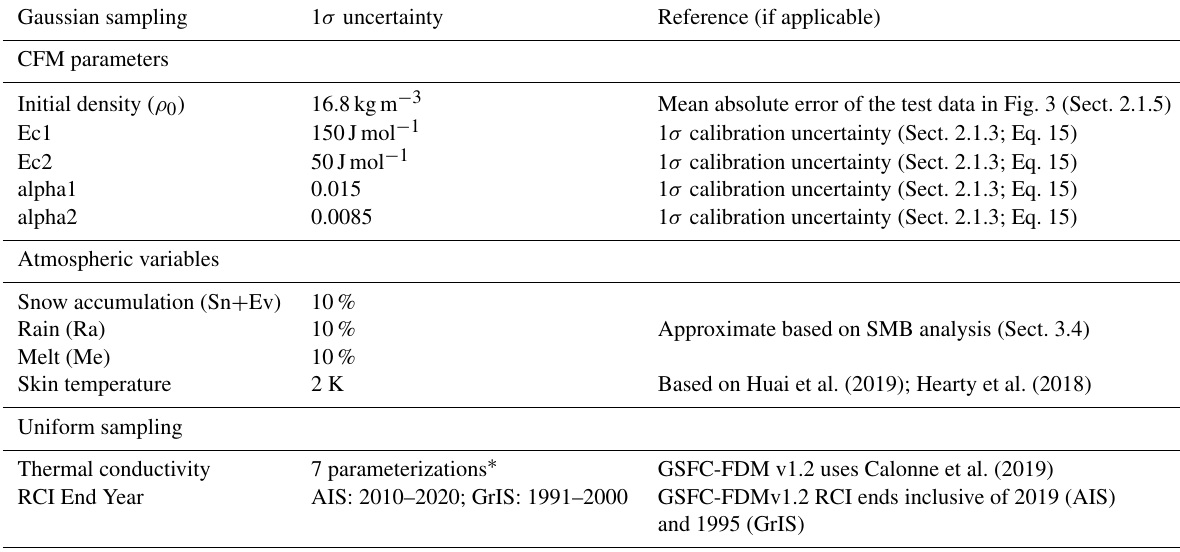
Table 1. The 1 σ (standard deviation) uncertainties in various CFM parameters and atmospheric forcing provide the basis of our uncertainty analysis (Sect. 2.5). We also uniformly sample two assumptions regarding model setup: the thermal conductivity and RCI end year. The perturbation developed samples randomly from a Gaussian distribution with a mean of zero and a standard deviation provided within the table. The values used are either based on analysis within this work or based on other references